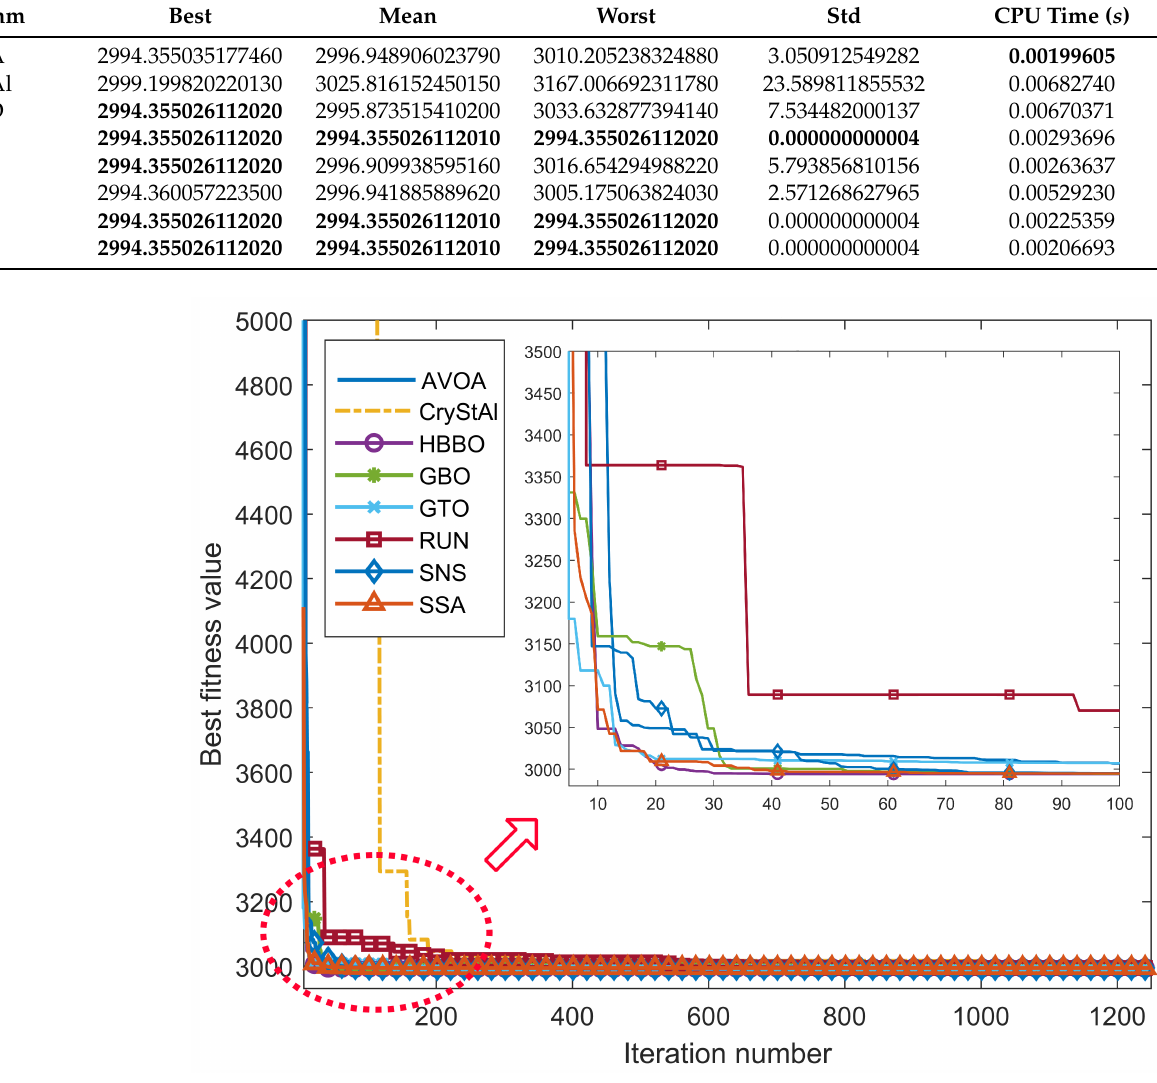
Figure 6. Best run convergence curves of each meta-heuristic algorithms (out of 100 repetitions) in the reduction gear design optimisation